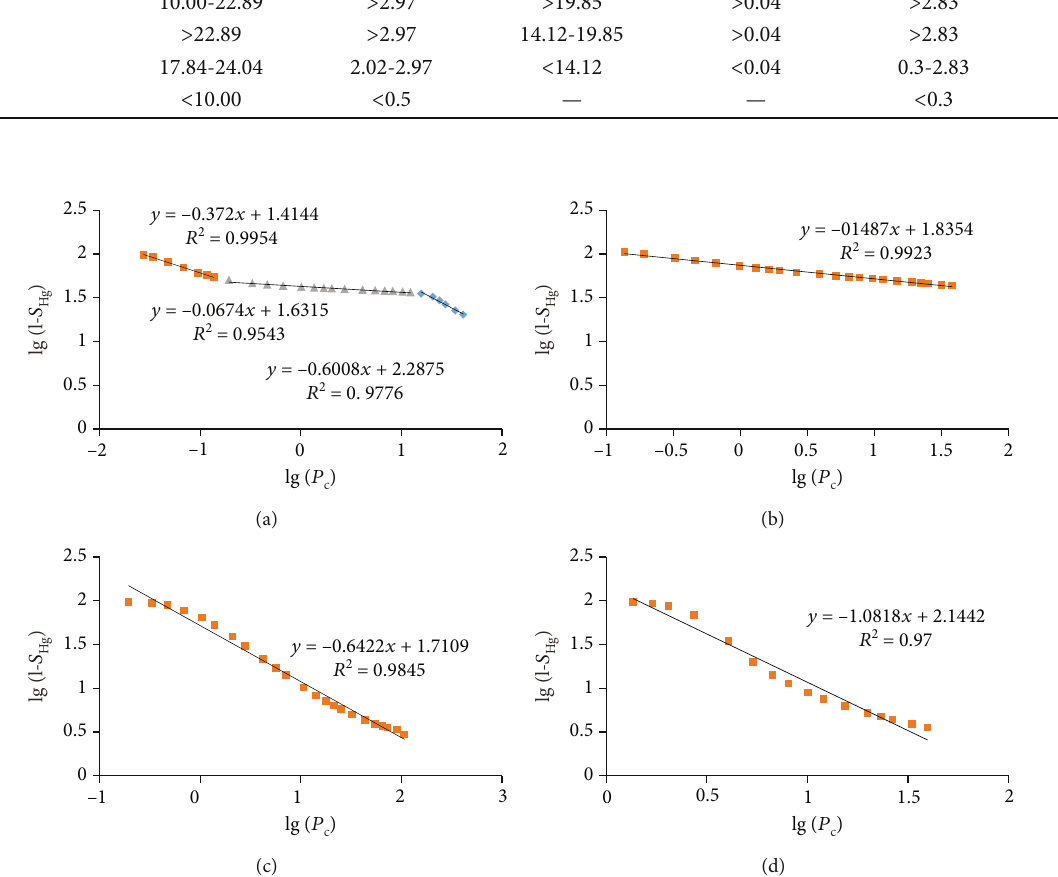
Figure 12: Representative sample plots of lg S ); (c) type III (well H11, 2611.41m, Kh 2664.45m, Kh 2